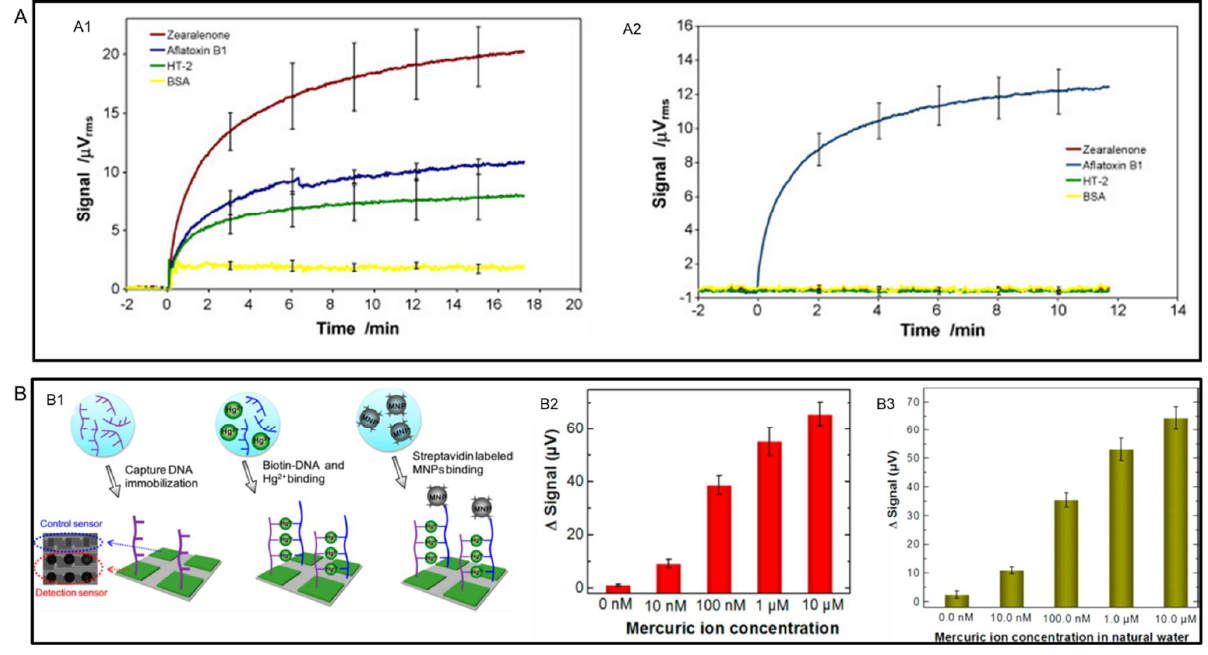
Figure 7. ( A , A1 ) Real-time binding curves of AFB1, zearalenone and HT-2 at 33 ng/mL concentration. ( A2 ) Cross-reactivity detection results of anti-AFB1, anti-zearalenone and anti-HT-2. ( B , B1 ) Schematic diagram of the DNA assay for Hg 2+ detection. ( B2 ) Average signals for mercuric ions with different concentrations in a buffer. ( B3 ) Average signals for mercuric ions with different concentrations in natural water. ( A ) is reprinted with permission from Ref. [101], Copyright 2010, Elsevier B.V. ( B ) is reprinted with permission from Ref. [102], Copyright 2014, American Chemical Society.